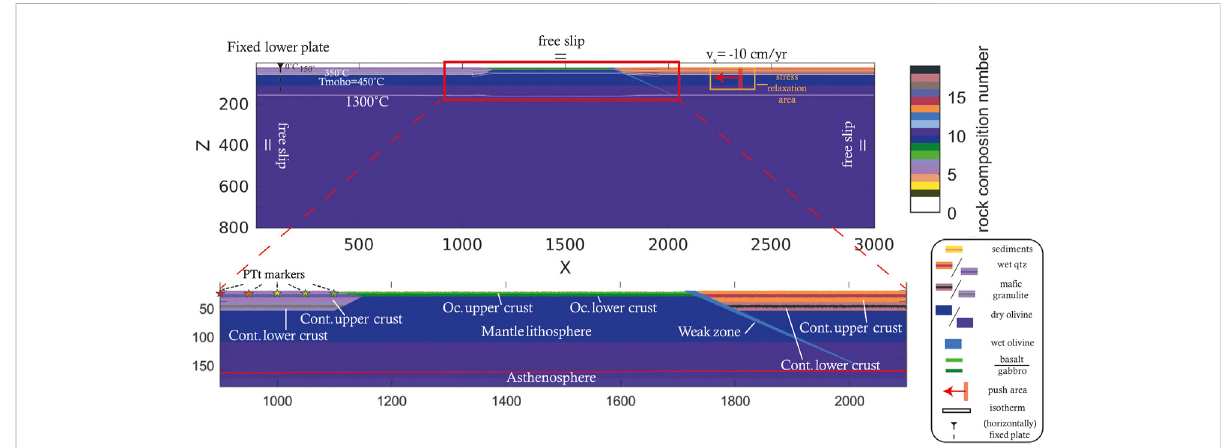
FIGURE 2 Illustration of the setup used in this study showing boundary conditions, lithological strati fi cation and isotherms. Note that the length of the oceanic plate isvaried inone of the parameter studies. Initial convergence of10 cm/yr is applied in thered box around x = 2,300 km until 500 km of convergence has been accommodated. Stress changes are relaxed in the area indicated by the orange box around the push area to avoid arti fi cial stresses. Finally, the initial position of fi ve markers in the downgoing plate, used for pressure, temperature and time tracking are shown with